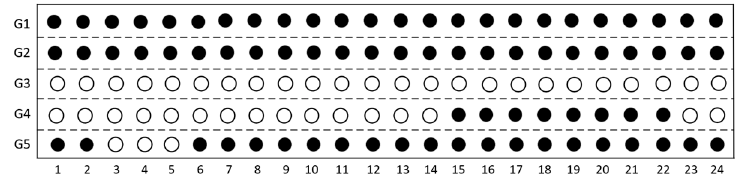
Figure 9. Commitment status of unit day-ahead in Case 4.